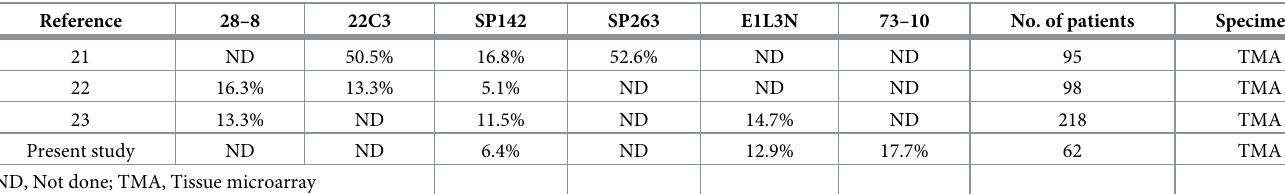
Table 9. Comparison of PD-L1 expression among different primary